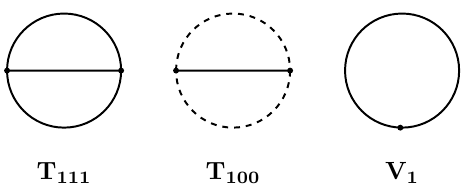
Figure 2. Two-loop and one-loop master integrals. The line coding is the same as in (cid:12)gure